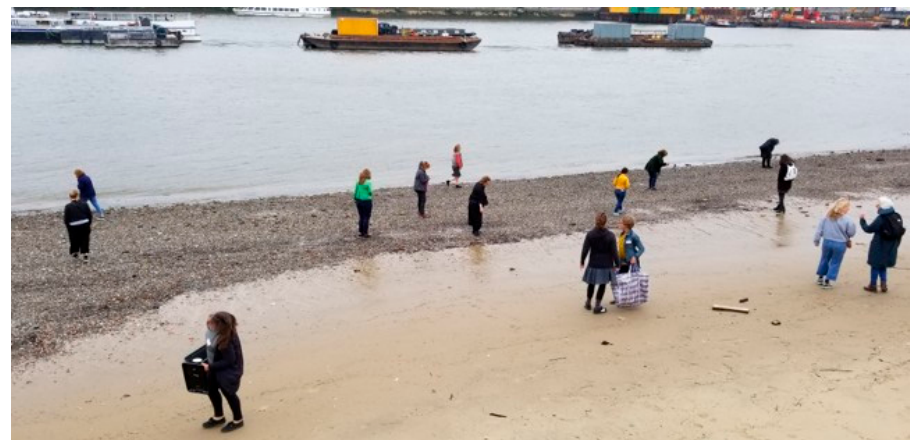
Figure 1. Participants in Thinking through Drawing Symposium, Mudlarking on the Thames and selecting rocks to be drawn in workshop. Photo courtesy of Michael Moore.